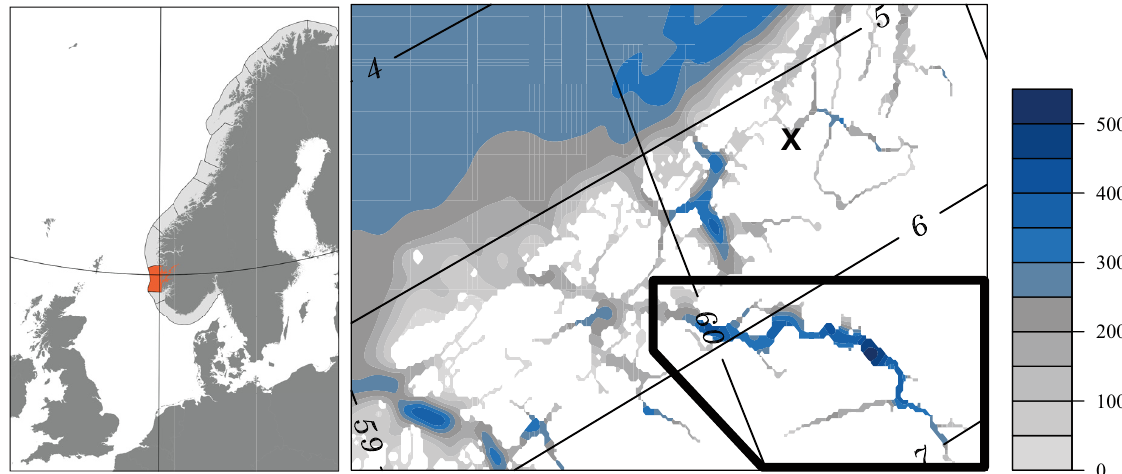
Fig. 1. Hardanger area and model domain with bathymetry (m). The black box is the area assessed for possible mussel farms (also used for the statistics of primary and secondary production), and X indicates the location of